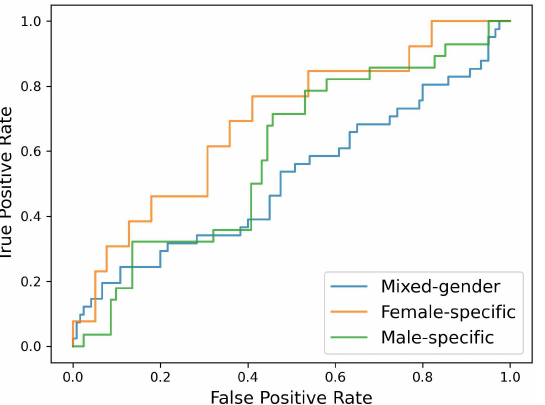
Figure 4. Pooled ROC curve for the best-performing mixed-gender, male-specific, and female- specific